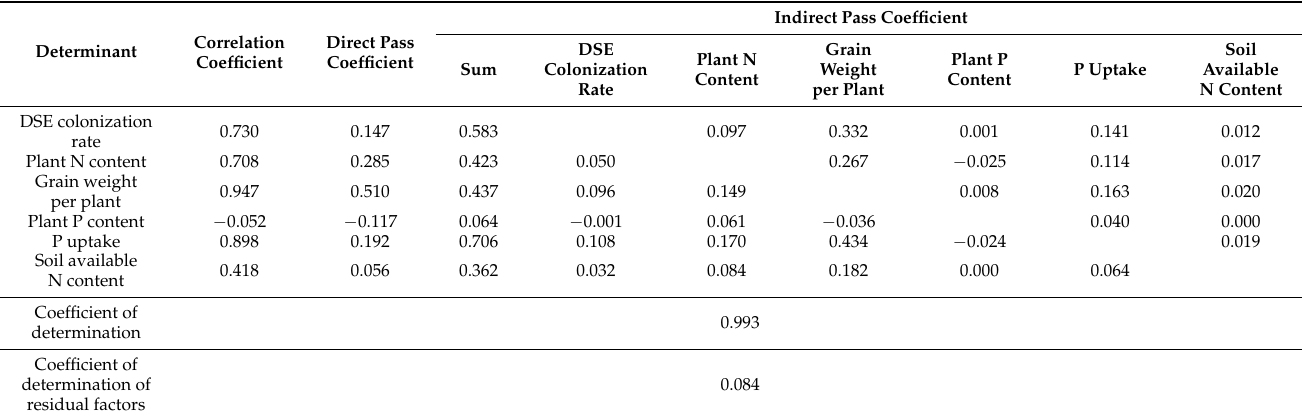
Table 5. Path analysis of yield determinants of buckwheat.